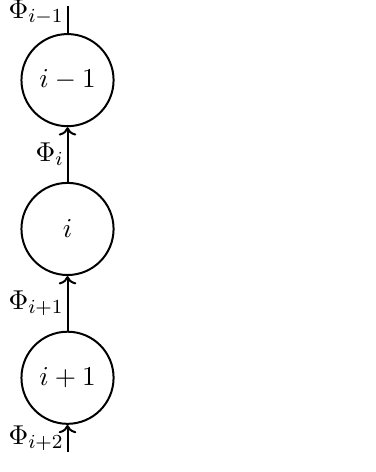
and s r, + (the c c +1